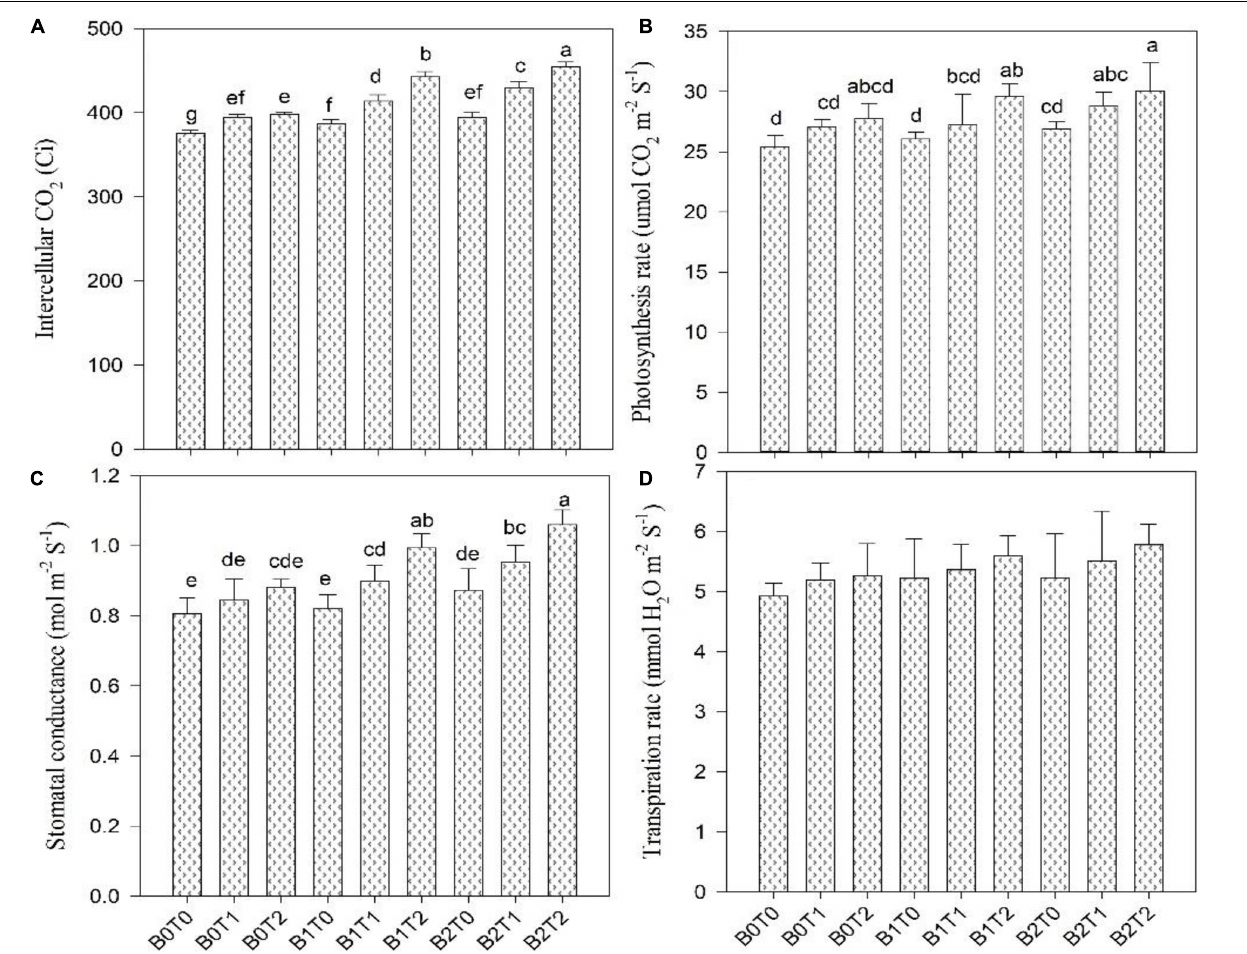
Figure 5 | Effect of combined application of TU and BC on (A) intercellular CO 2 , (B) photosynthesis rate, (C) stomatal conductance, and (D) transpiration rate grown under Cd contamination. Values are averages ± SD ( n = 3). Different statistical letters represent significant differences in values between treatments ( p < 0.05). TU, thiourea; BC, biochar; T 0 = 0 mg L − 1 ; T 1 = 600 mg L − 1 ; T 2 = 600 mg L − 1 ; B 0 = 0% w/w; B 1 = 2.5% w/w; B 2 = 5.0% w/w.